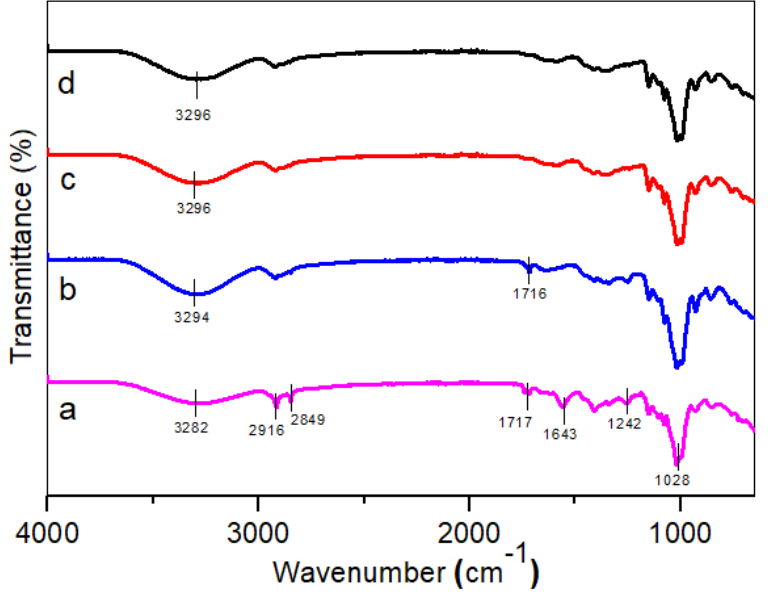
Figure 1. FT-IR spectra of ( a ) untreated, ( b ) 3 wt.%, ( c ) 6% wt.%, and ( d ) 9 wt.% of TPCS/PW/CCF composites.